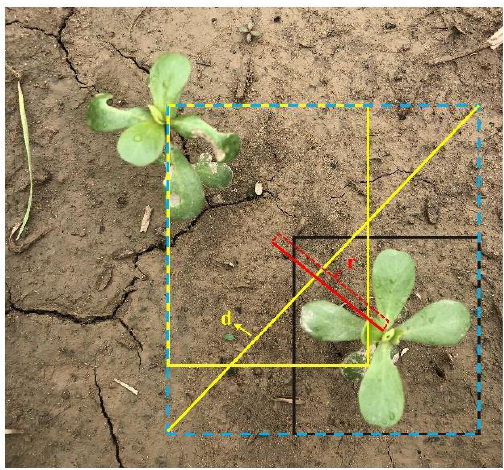
Figure A2. CIoU diagram, where r represents the center point distance d of the two detection boxes, and d represents the distance between the diagonals of the smallest rectangle containing the two detection boxes.